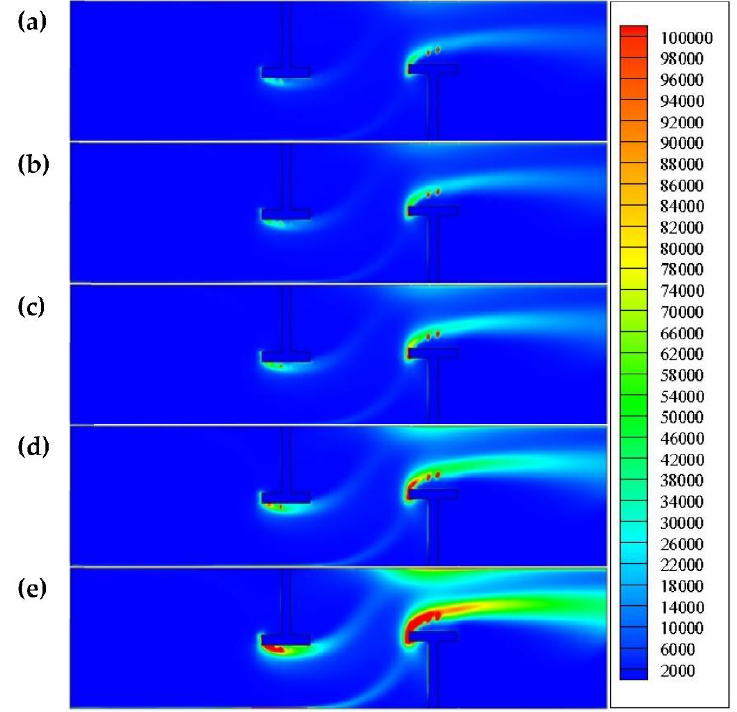
Figure 9. Fields of the turbulent dissipation rates for: Re = ( a ) 12,000; ( b ) 17,000; ( c ) 22,000; ( d ) 27,000; ( e ) 32,000.